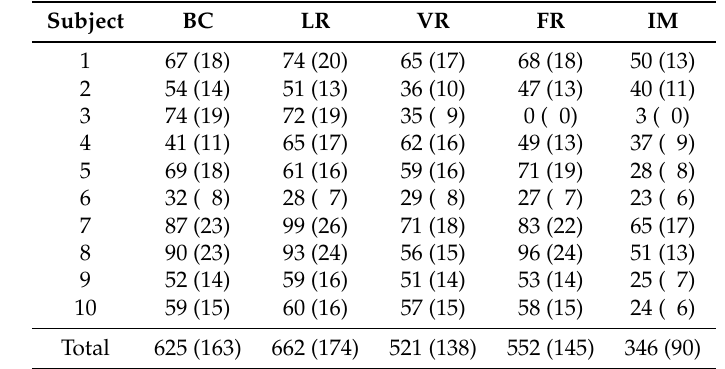
Table 2. Database consistency: recorded duration for each exercise type and subject [seconds (number of feature